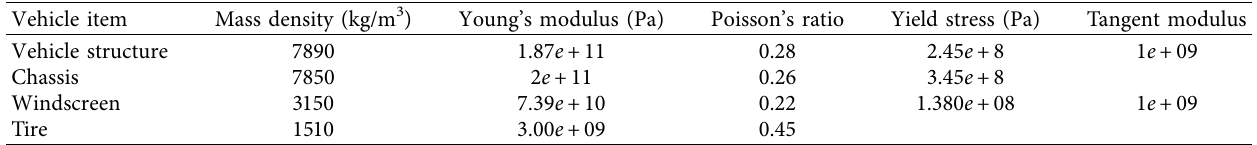
Table 1: Mechanical properties of a vehicle component.